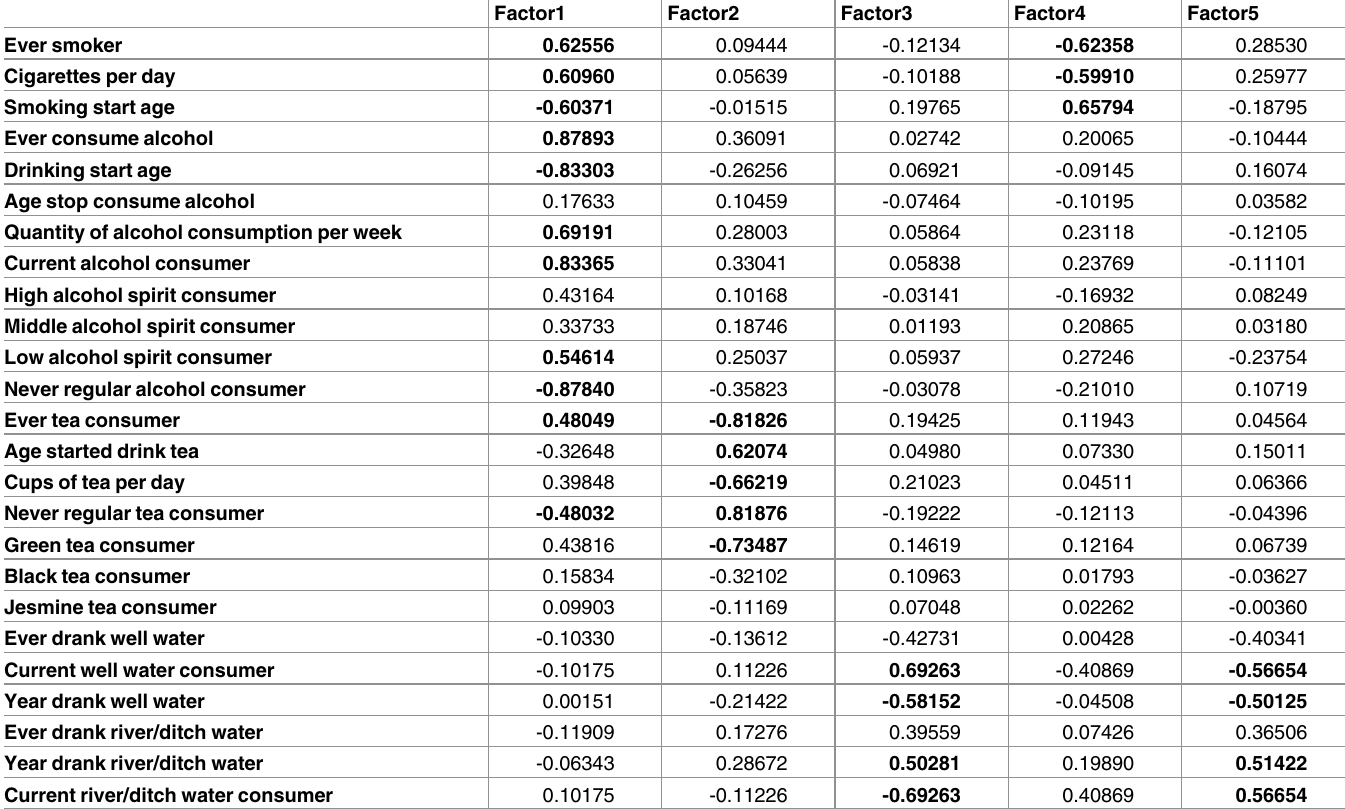
Table 2. Lifestyle and environmental factors explained by loading of variables from factor